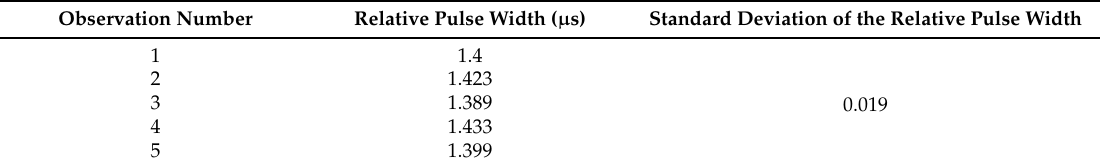
Table 3. Statistical data of the proposed optical-fiber PWM pH-sensing elements with methyl red, including sensing membrane in a buffer solution with pH of about 7 for the five